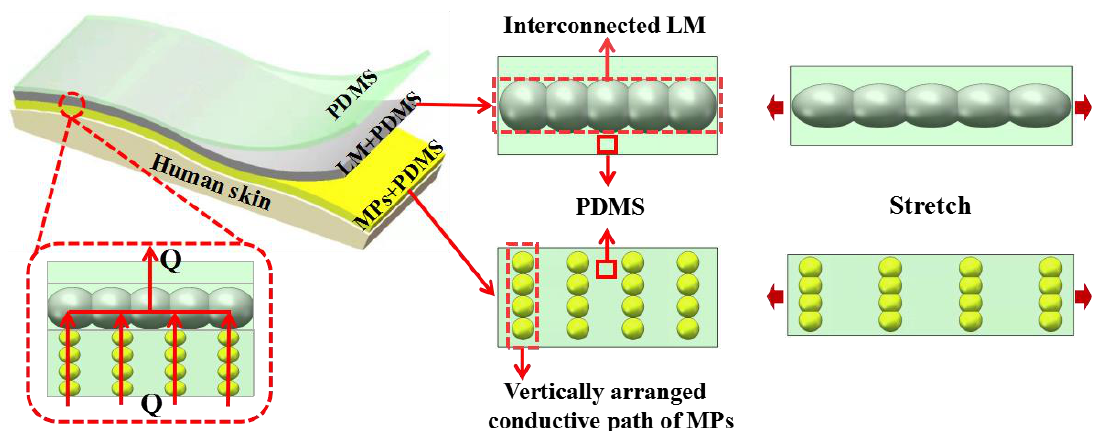
Figure 1. Design principle of three-layered elastic surface electromyography (sEMG) electrode (polydimethylsiloxane (PDMS) / galinstan (LM) + PDMS / silver-coated nickel (MPs) + PDMS). Sensor layers are in the configuration: top layer (PDMS) / intermediate layer (LM + PDMS) / bottom layer (MPs + PDMS). Inset, figure showing the flow of the sEMG charge generated from the skin.